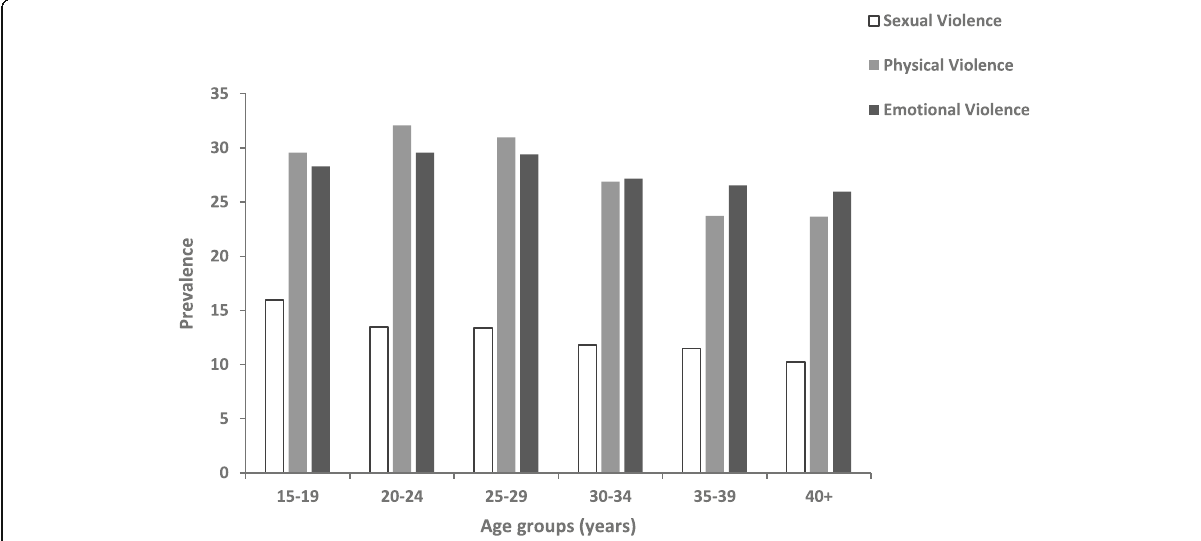
Fig. 2 Prevalence of IPV among women of reproductive age (15 – 49 years) by age group, Zimbabwe, pooled data, 2005 –